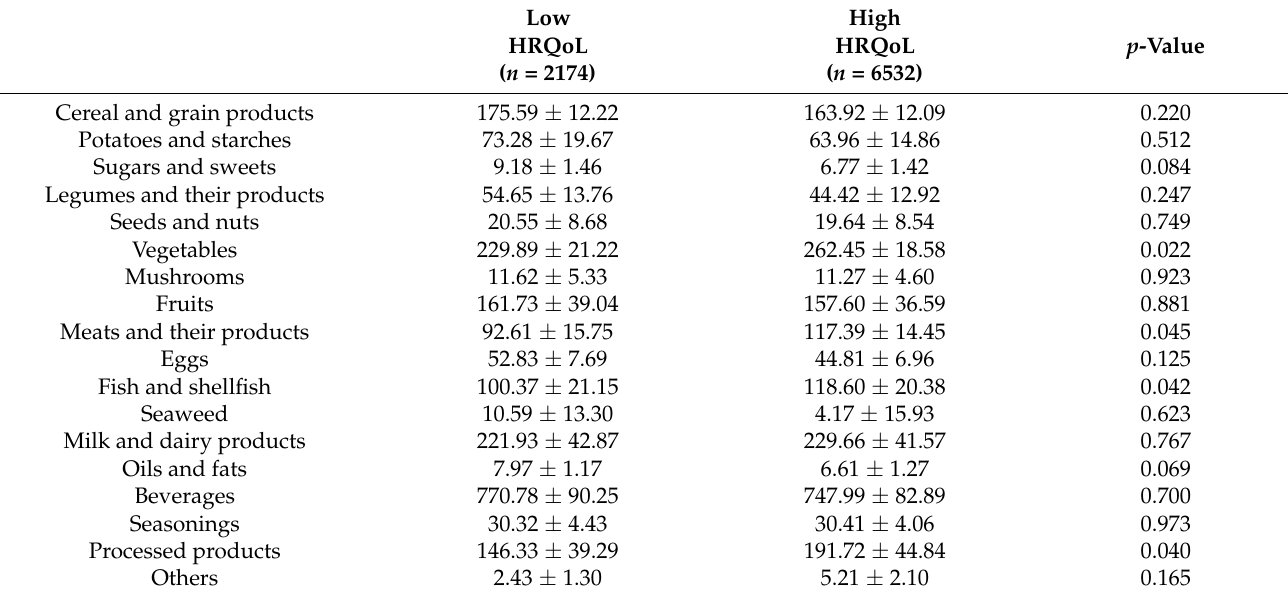
Table 3. Food group intake of females according to HRQoL among Korean adults ( n = 8706).